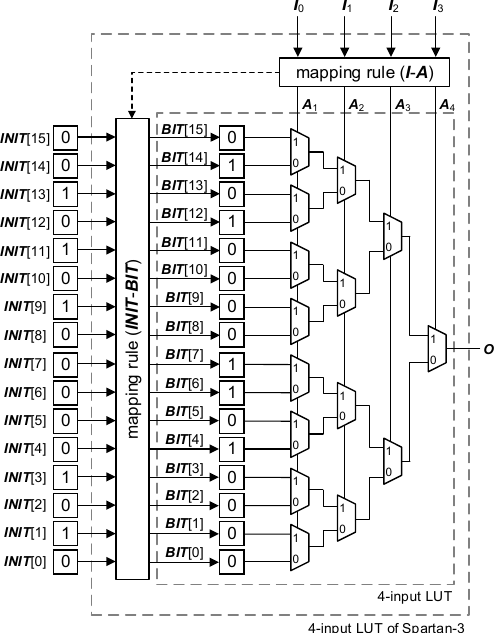
Figure 3. Actual 4-iput LUT structure in Xilinx Spartan-3.